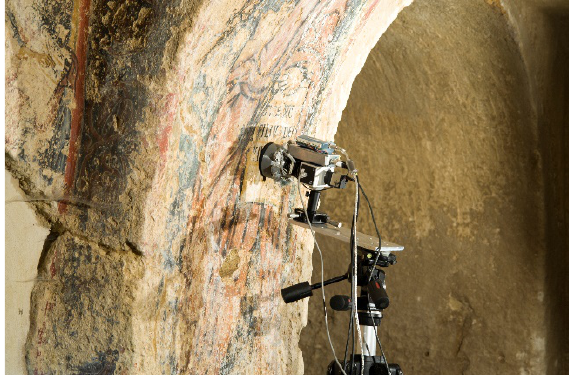
Figure 4. Mapping of organic contaminants with portable UV multispectral fluorescence microscope.